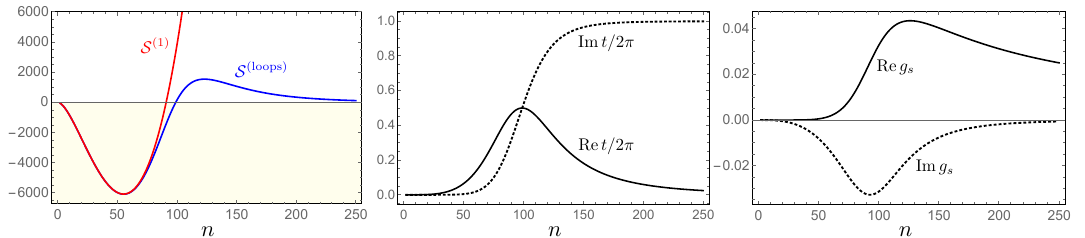
Figure 4 . One- and all-loop entropy corrections, and dual topological string t , g s , for 3D HS n theory in its maximal-entropy de Sitter vacuum, for different values of n at fixed S (0) = 10 8 , l = 0